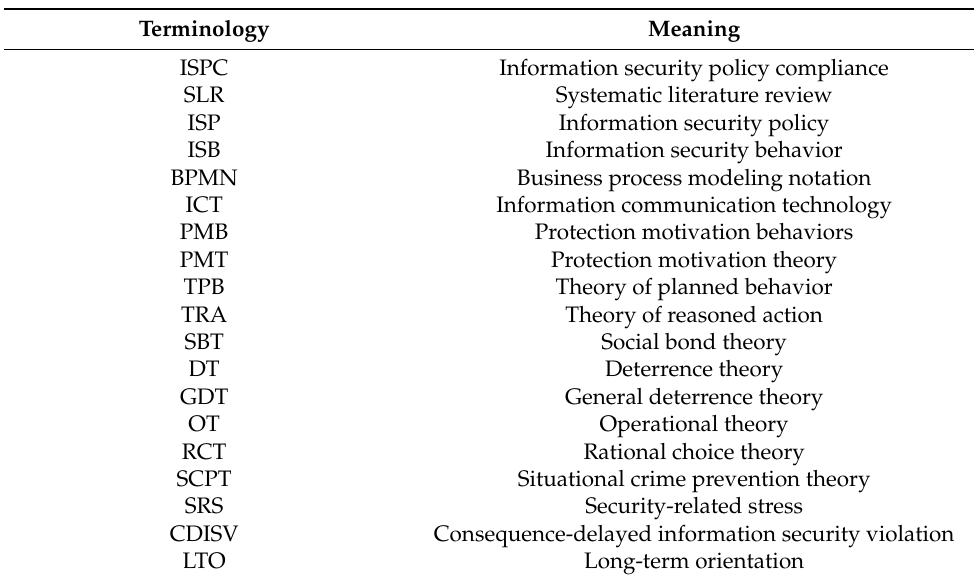
Table A6. Terminologies used in the